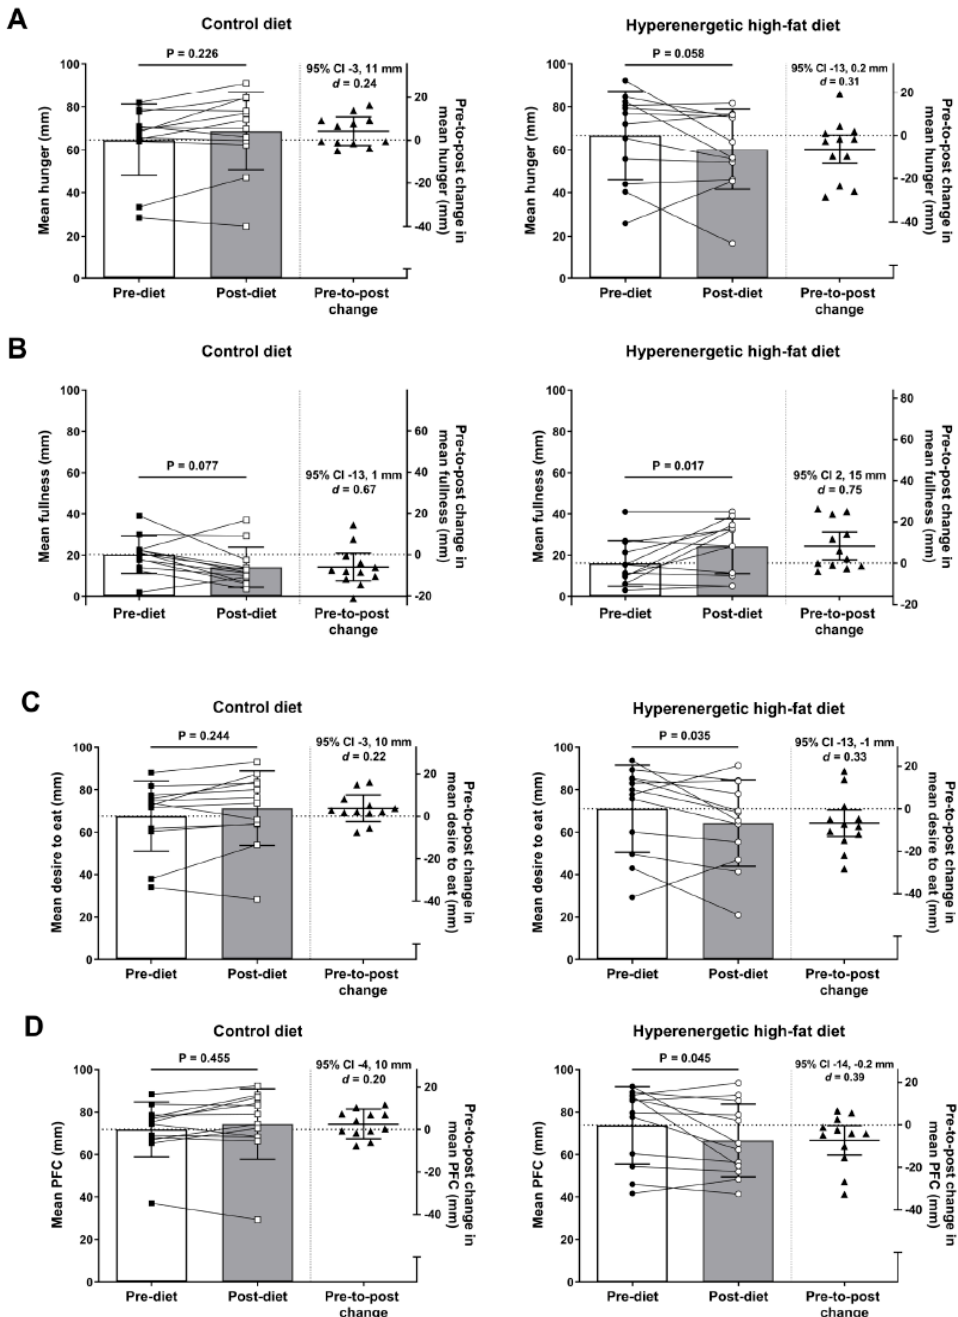
Figure 3. Mean ratings of perceived ( A ) hunger, ( B ) fullness, ( C ) desire to eat, and ( D ) prospective food consumption (PFC) during the oral glucose tolerance test before (pre-diet) and after (post-diet) the seven-day control diet (left panels) and hyperenergetic high-fat diet (HE-HFD) (right panels) in 12 healthy men. The left-hand y axis displays the pre-diet and post-diet appetite data separately: bars and error bars represent the mean (SD), and data points (squares (cid:4) , (cid:3) and circles • , ) and connecting lines represent the pre- and post-diet individual data values. The right-hand y axis displays the pre-to-post diet change in appetite: the horizontal lines represent the mean di ff erence (95% confidence interval (CI) of the mean absolute di ff erence), and the triangles ( (cid:78) ) indicate the pre-to-post change for each participant. Displayed p values, 95% CI (of the mean di ff erence) and e ff ect sizes (Cohen’s d ) are from the post-hoc analysis of diet-by-time interactions for hunger p = 0.030, fullness p = 0.004, desire to eat p = 0.022, and PFC p = 0.053.